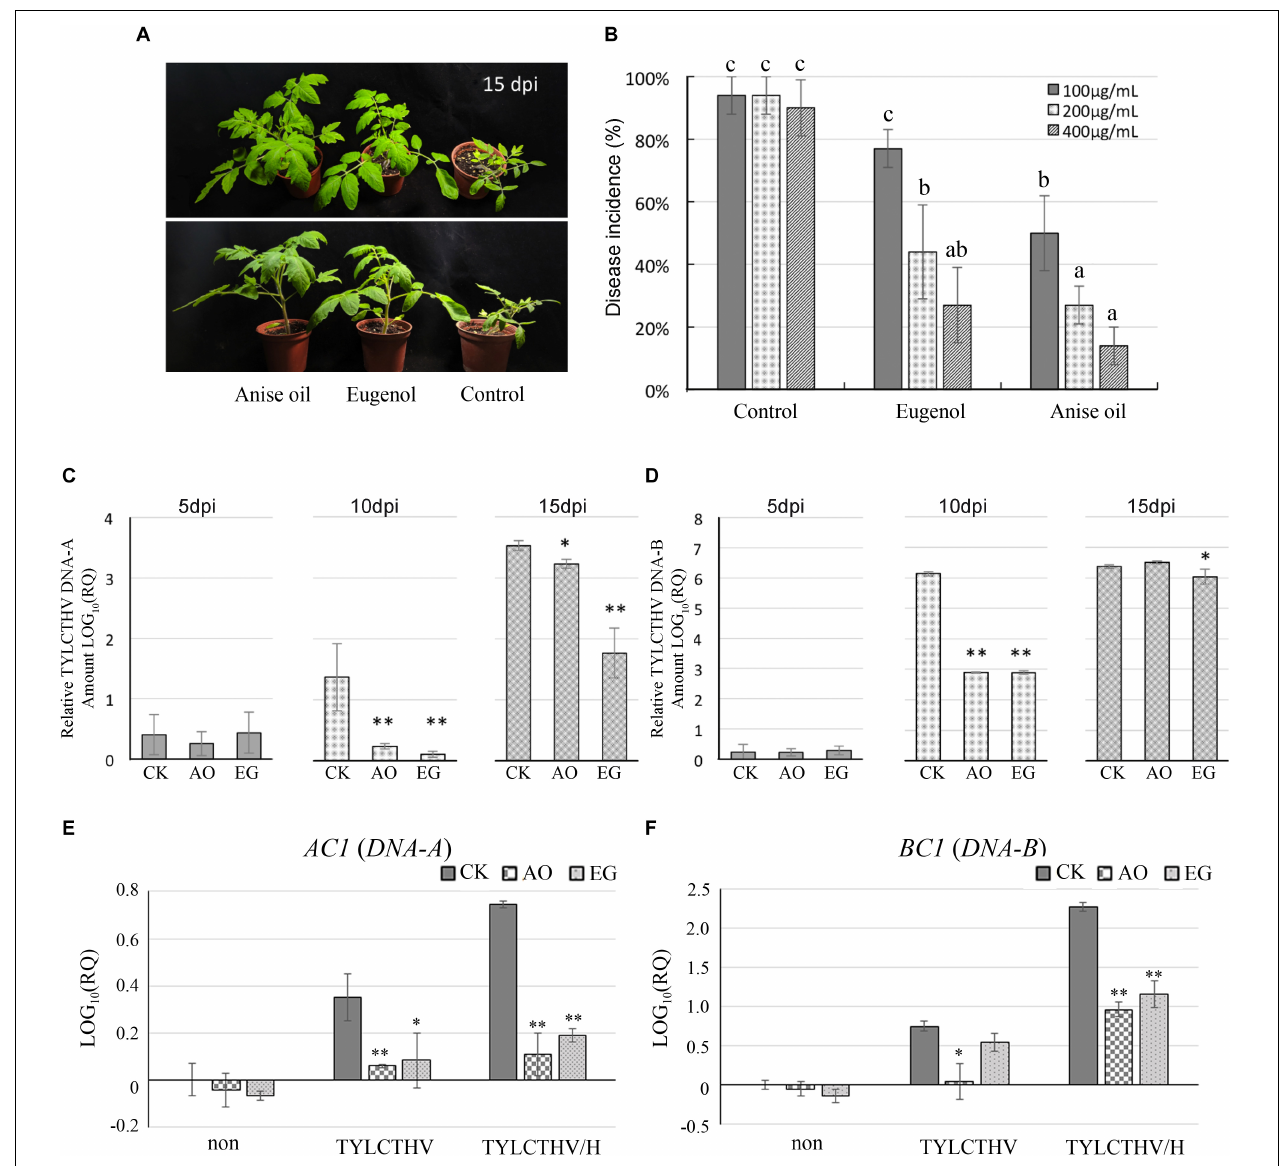
FIGURE 3 | Antiviral effects of anise oil and eugenol on TYLCTHV. Tomato plants were treated with foliar applications of eugenol (100, 200, or 400 µ g mL − 1 ) or anise oil (100, 200, or 400 µ g mL − 1 ) 24 h before TYLCTHV inoculations. The plants were photographed at 15 days post-inoculation (dpi) (A) . The disease incidence was evaluated by detecting TYLCTHV-positive plants at 15 dpi. Fisher’s least significant difference test (LSD) was employed examining significant differences ( P < 0.05) among different treatments. (B) . Additionally, the relative abundances of TYLCTHV DNA-A (C) and DNA-B (D) in anise oil- and eugenol-treated plants and control were estimated by a quantitative real-time PCR assay. Samples were collected every 5 days after the onset of the viral infection (0, 5, 10, and 15 dpi). Five individual samples for each treatment were analyzed. Relative TYLCTHV DNA amounts in tomato plants were normalized against the DNA content at 0 dpi. In addition, relative expression of viral RNA, AC1 (E) and BC1 (F) , at 5 dpi was also analyzed by RT-qPCR. The β -actin expression level was used as the internal control. Relative gene expression levels were normalized against the expression level in control. Data were analyzed with the 2 − (cid:49)(cid:49) Ct method. Bars represent the mean ( ± standard error of the mean) of at least three independent biological replicates each with three technical replicates. Significant differences between control and anise oil- or eugenol-treated plants were assessed with Student’s t -test ( ∗ P < 0.05; ∗∗ P <